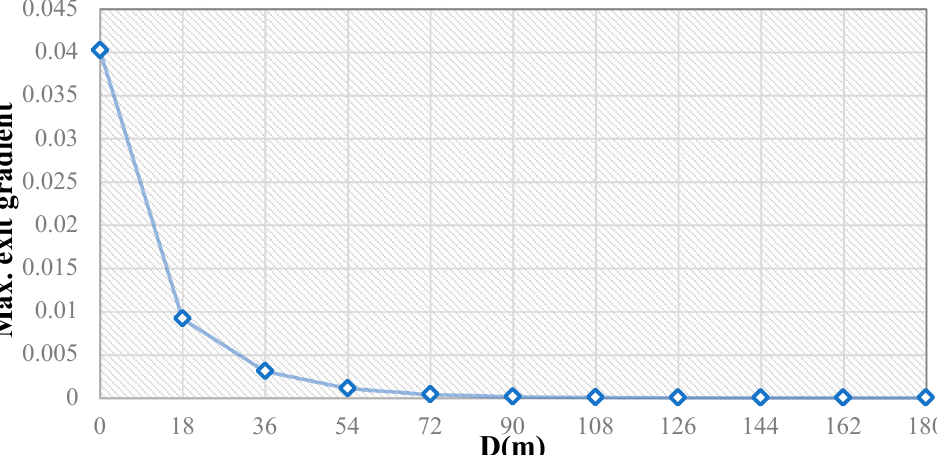
Figure 18. Uplift pressure under the core for different lengths for drainage system.